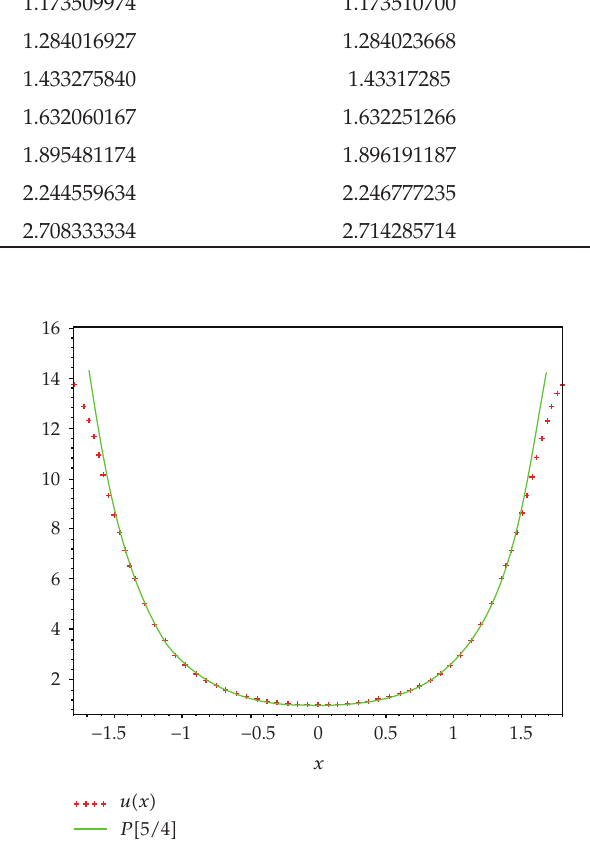
Figure 1: Values of u (cid:7) x (cid:8) and its P (cid:3) 5 / 4 (cid:4) Pad´e